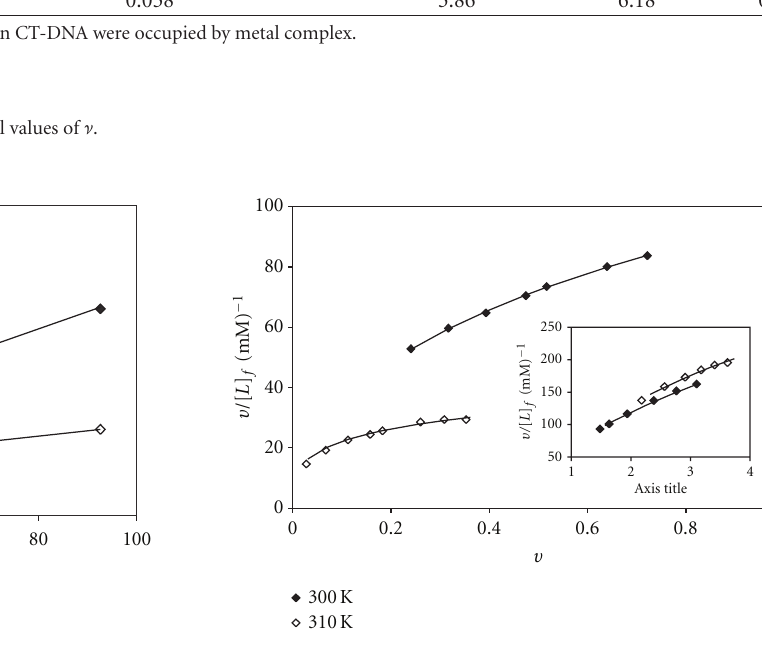
Figure 5: The changes in the absorbance of fixed amount of each metal complex in the interaction with varying amount of CT-DNA at 300K and 310K. The linear plot of the reciprocal of Δ A versus the reciprocal of [DNA] for [Pt(bpy)(Oct-dtc)]NO 3 and the inset for [Pd(bpy)(Oct-dtc)]NO 3 .